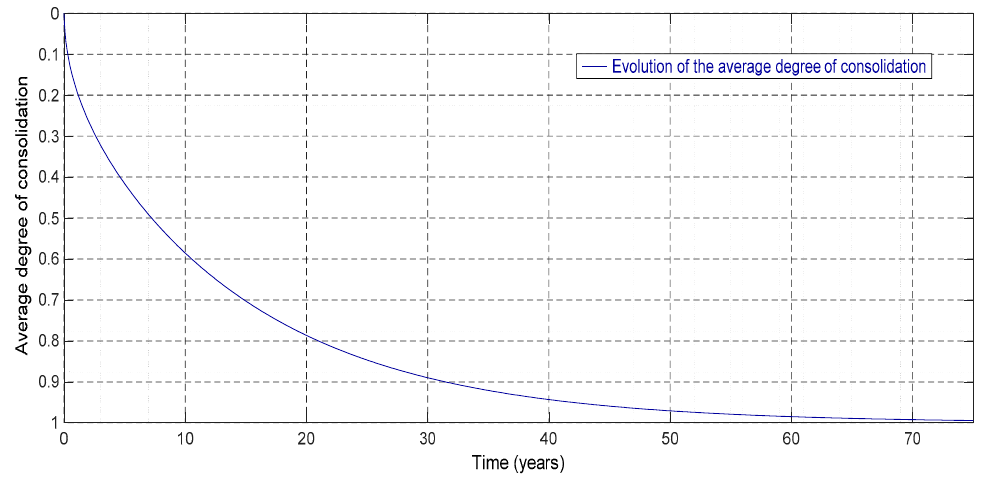
Figure 16. Average degree of settlement for the case with no PVDs.